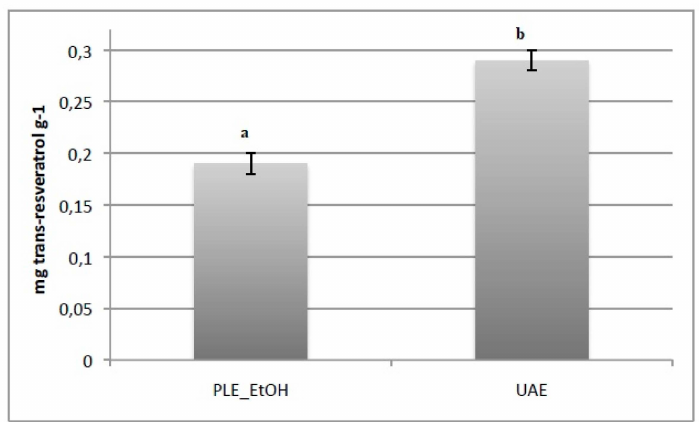
Figure 1. Trans -resveratrol content in PLE and UAE extracts. Samples with di ff erent superscript letters di ff er significantly ( p <